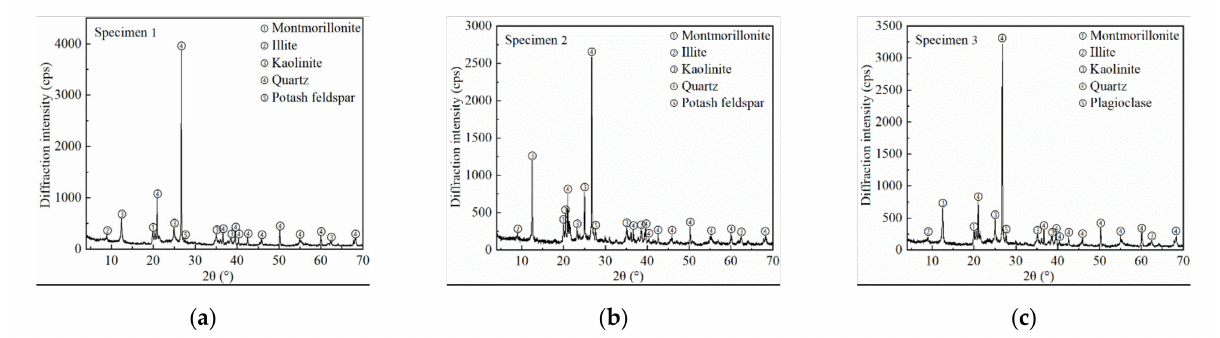
Figure 9. X-ray diffraction patterns of weakly cemented mudstone: ( a ) Specimen 1; ( b ) Specimen 2; ( c ) Specimen